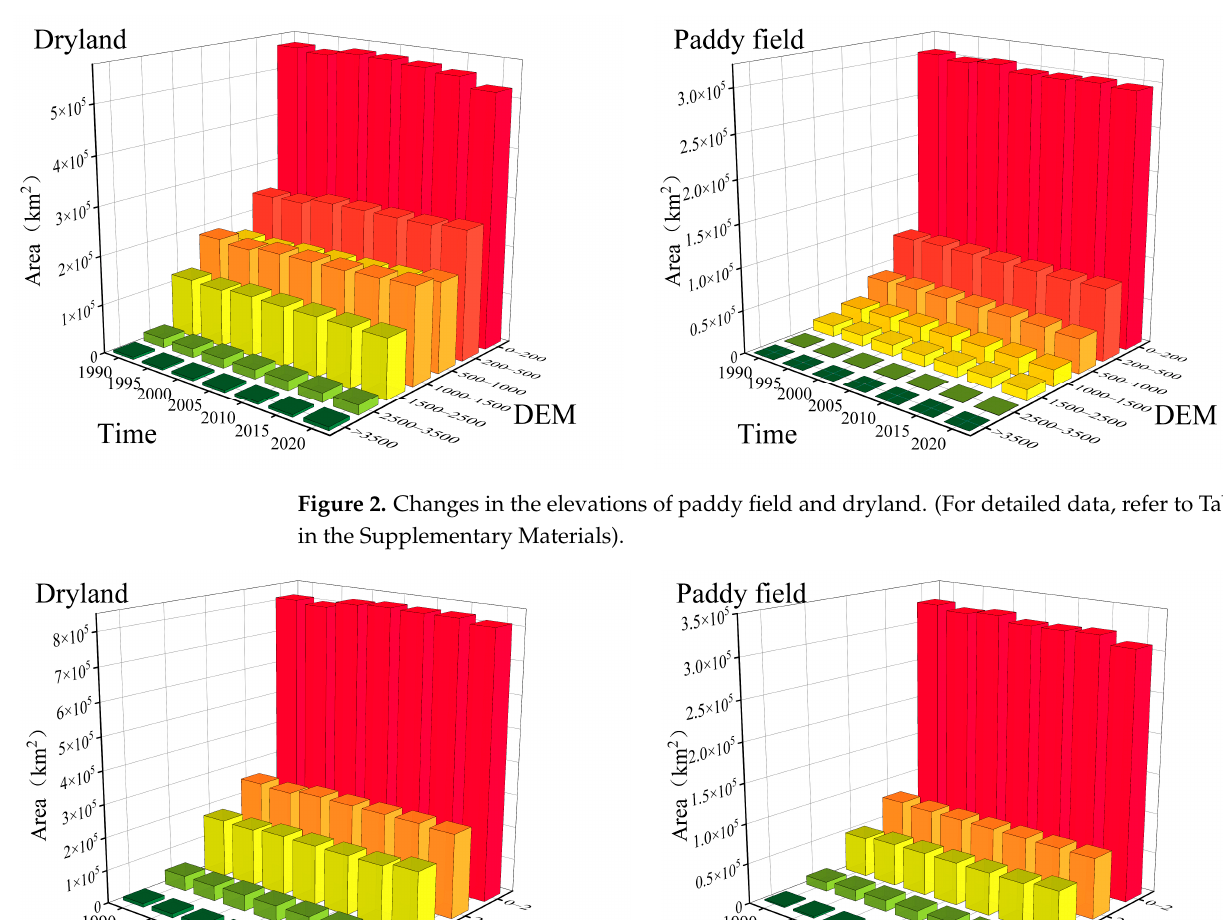
Figure 2. Changes in the elevations of paddy field and dryland. (For detailed data, refer to Table S2 in the Supplementary Materials).